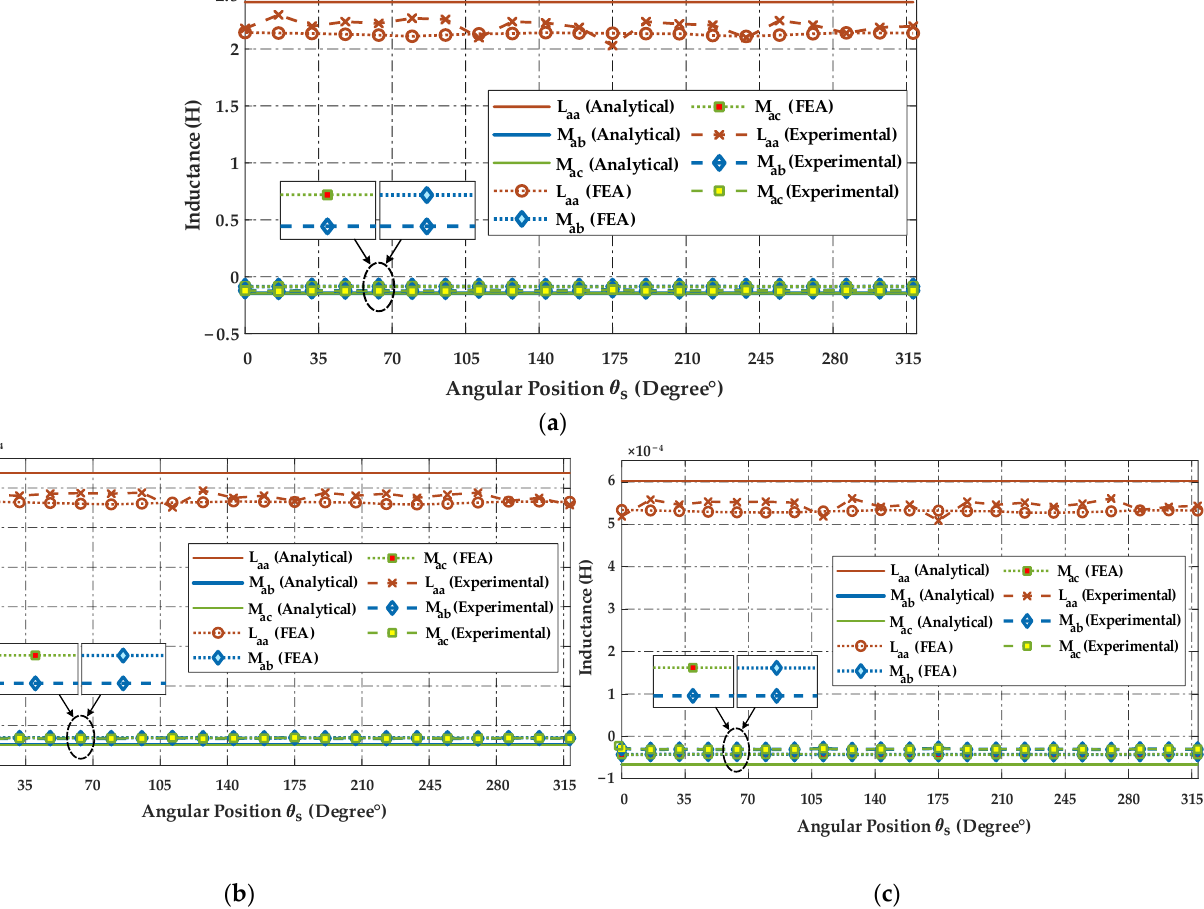
Figure 12. Comparison between inductances derived by the analytical approach, FEA, and experi- mental measurements. ( a ) Healthy inductances; ( b ) faulty inductances with 25% of LTs fault; ( c ) faulty inductances with 50% of LTs fault.